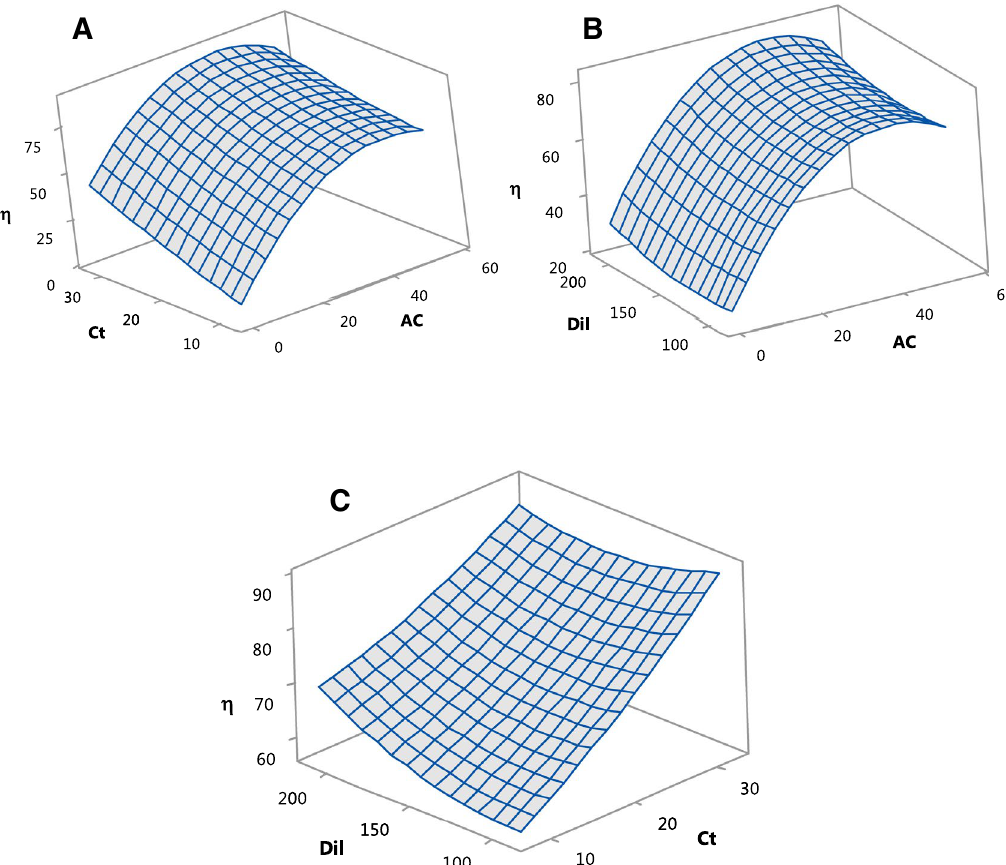
Figure 4. ( A ) Surface plot efficiency vs Ct and AC, at Dil = 1:150; ( B ) Surface plot efficiency vs Dil and AC, at Ct = 20 min; ( C ) Surface plot efficiency vs Dil and Ct, at AC = 27.5 g/L.